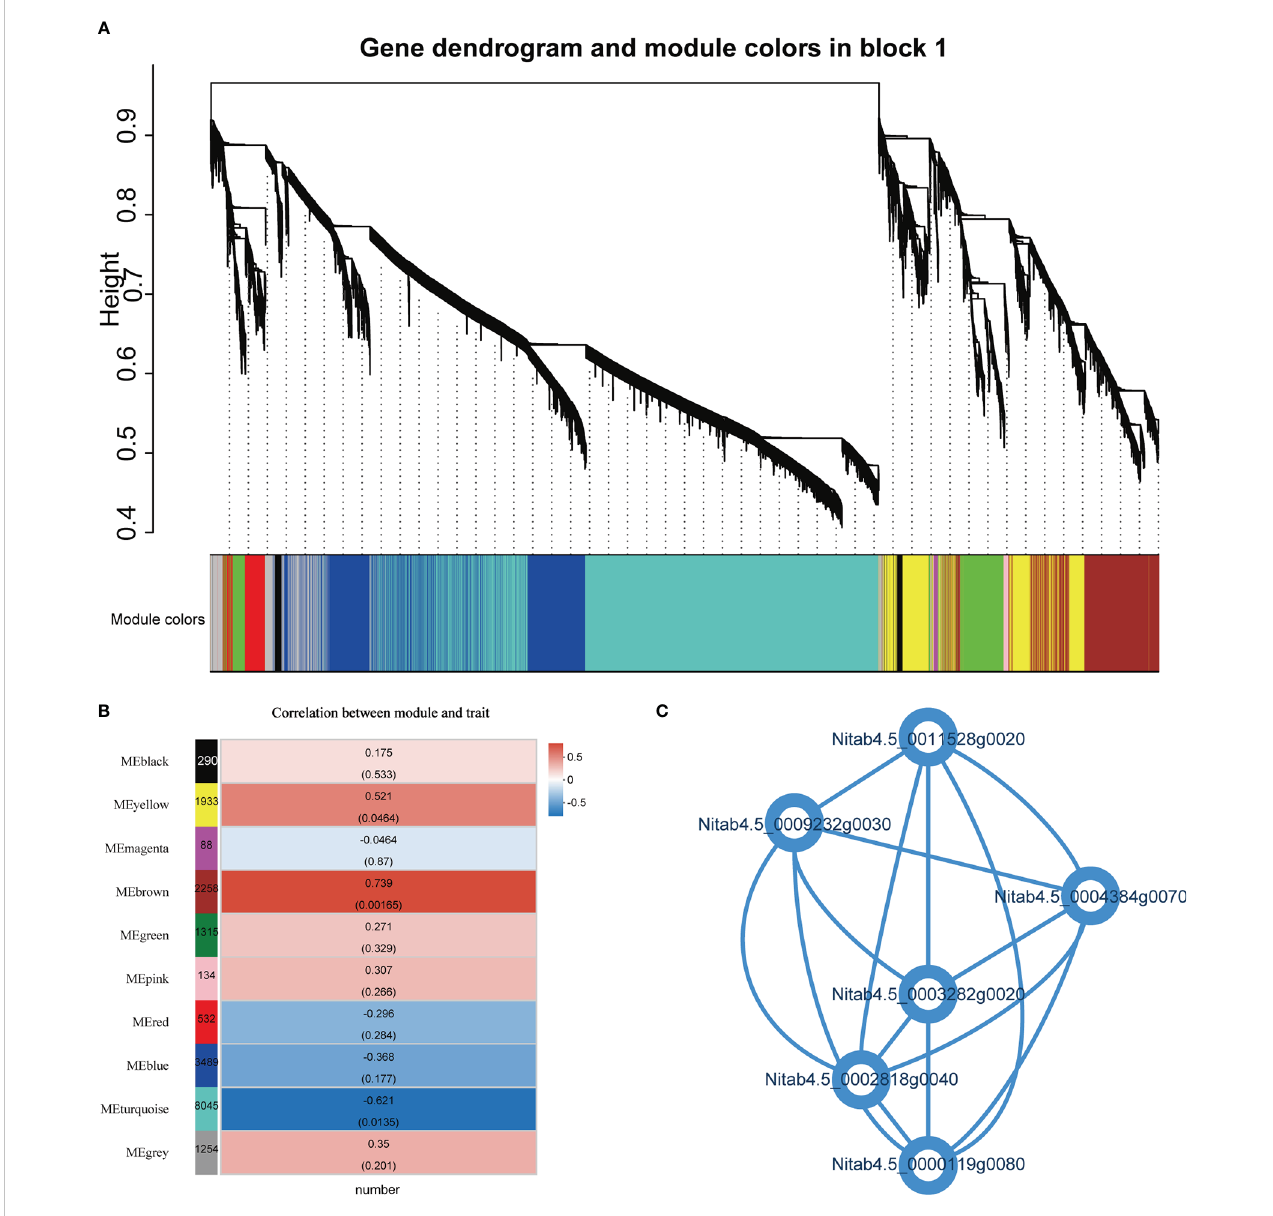
FIGURE 8 Weighted gene co-expression network analysis (WGCNA). (A) Hierarchical cluster tree shows 10 modules of co-expressed genes. The lower heatmap shows modules in designated colors. The module grey is for unassigned genes. (B) Heat maps showing the correlation of module-trait, the Pearson correlation coef fi cient and P values of signi fi cant modules are given. (C) Connectivity between 6